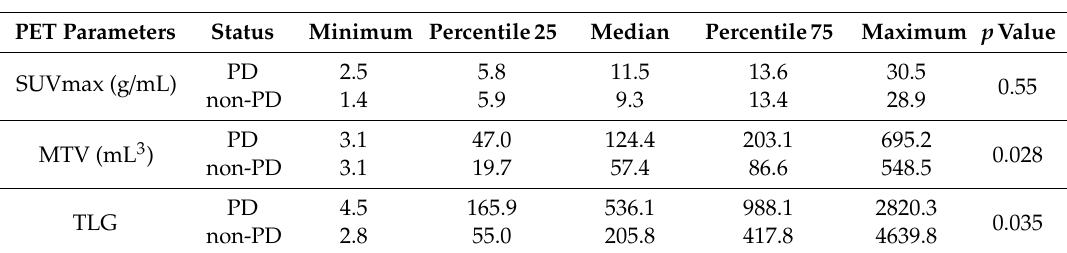
Table 3. SUVmax, MTV and TLG values among patients with progressive (PD) and non-progressive (non-PD) disease.